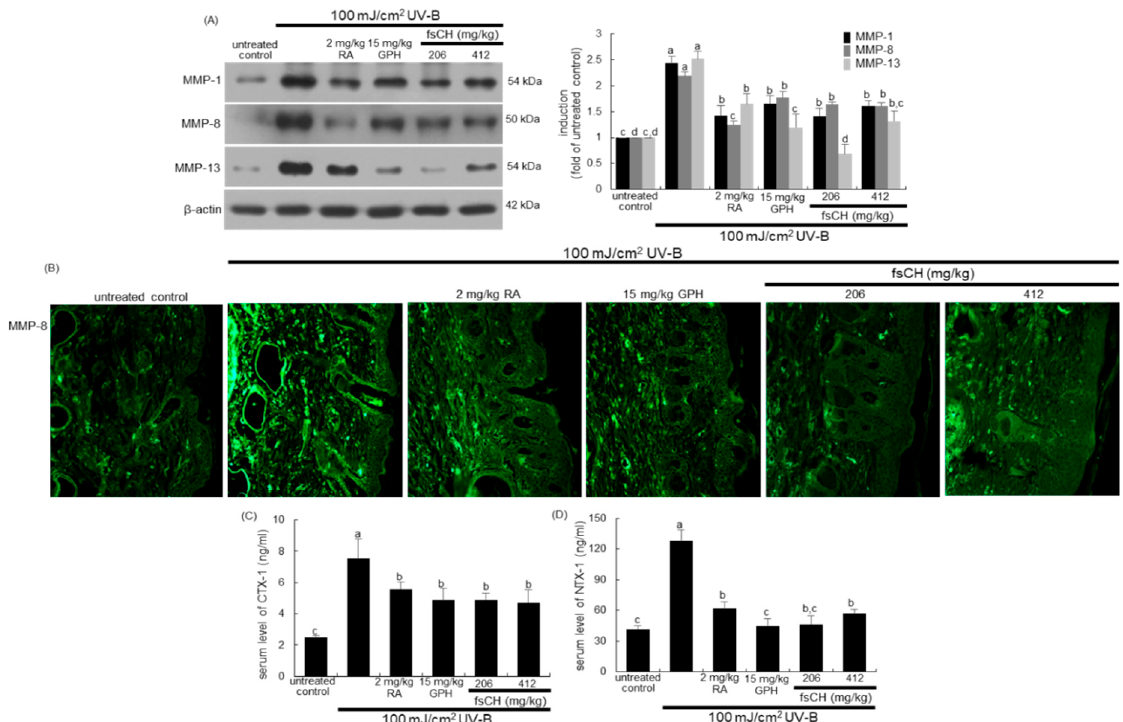
Figure 7. Effects of Pangasius hypophthalmus fish skin hydrolysates (fsCH) on dermal expression of matrix metalloproteinases (MMP) and collagen degradation in ultraviolet-B (UV-B)-irradiated SKH-1 hairless mice. SKH-1 hairless mice were exposed to UV-B radiation three times a week and treated with 2 mg/kg retinoic acid (RA) intraperitoneally and with 15 mg/kg glycine-proline-hydroxyproline tripeptide (GPH) and 206–412 mg/kg fsCH orally for eight weeks. Skin tissue extracts were electrophoresed on 8–12% SDS-PAGE and subjected to Western blot analysis with a primary antibody against MMP-1, MMP-8, and MMP-13 ( A ). β -Actin antibody was used as an internal control. The bar graphs (mean ± SEM, n = 3) in the right panels represent quantitative results of the blot bands on the left obtained from a densitometer. The skin tissue MMP-8 expression was immunohistochemically identified by FITC-green staining ( B ). Serum levels of carboxy-terminal telopeptide of type 1 collagen (CTX-1) and amino-terminal telopeptide of type 1 collagen (NTX-1) were measured by using ELISA kits (( C , D ), n = 7). Respective values in bar graphs not sharing a small letter are different at p <